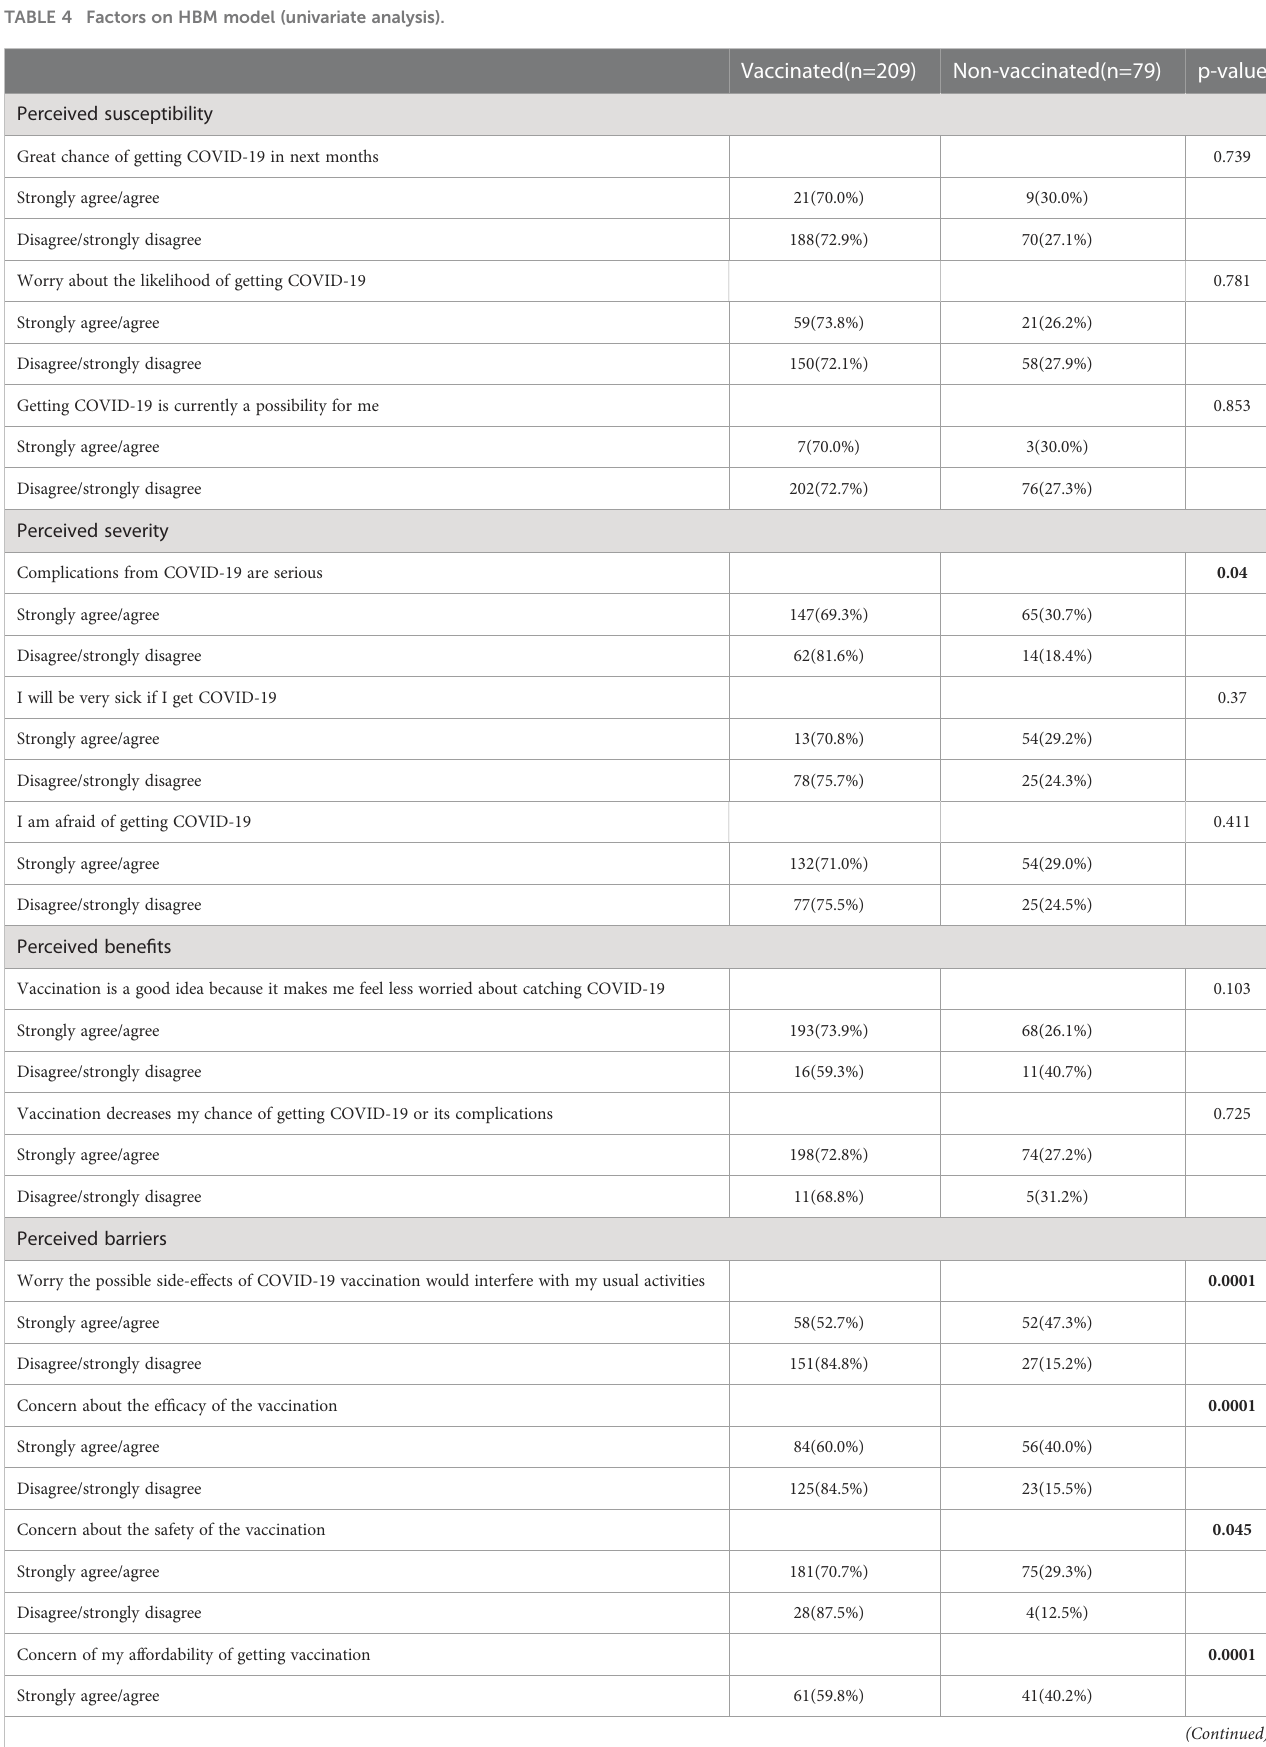
TABLE 4 Factors on HBM model (univariate